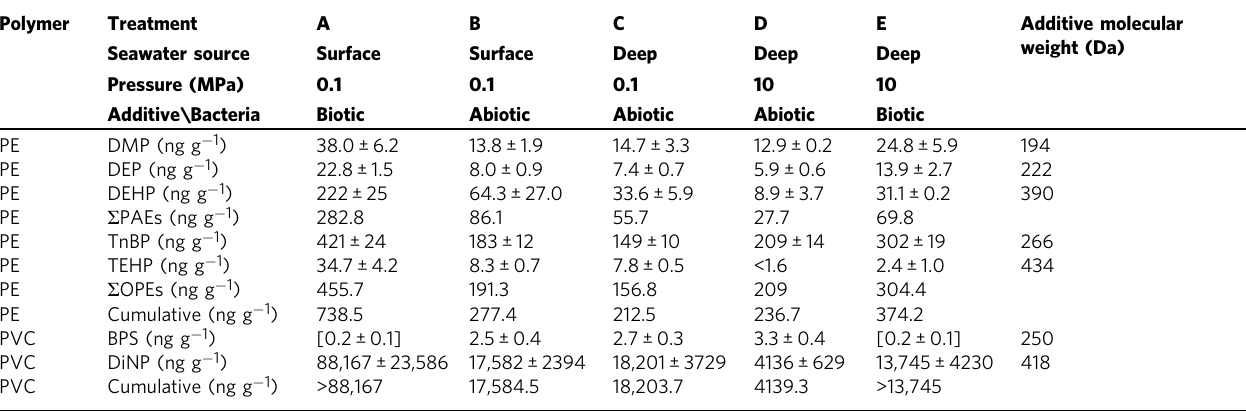
Table 1 Organic additive release from polyvinylchloride (PVC) and polyethylene (PE) to seawater under contrasting conditions of hydrostatic pressure and prokaryotic content for 30 days.